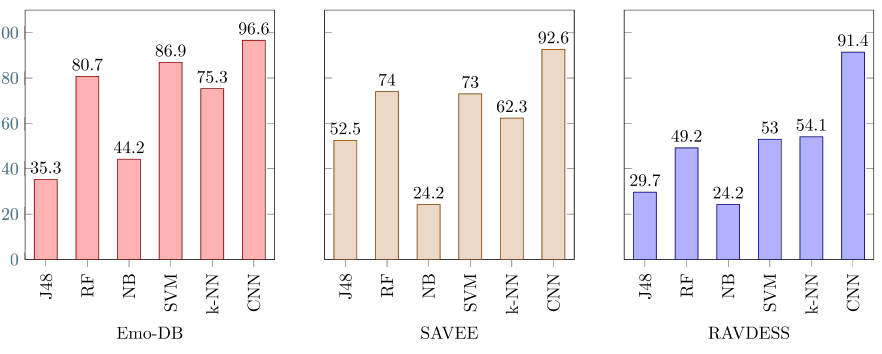
Figure 4. Weighted accuracies of the classifiers for the three datasets.